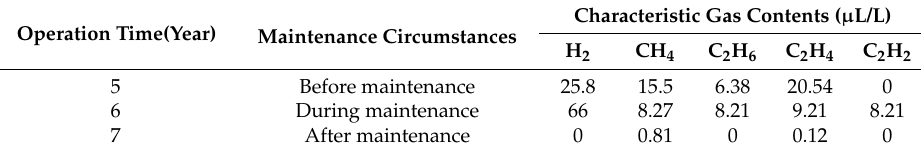
Figure 11. The failure rate curve of TOPIS in its sixth year of operation without considerations of the influences of oil separation. Table 4. The DGA data reference value of transformer when conducting a heavy oil filtering maintenance.